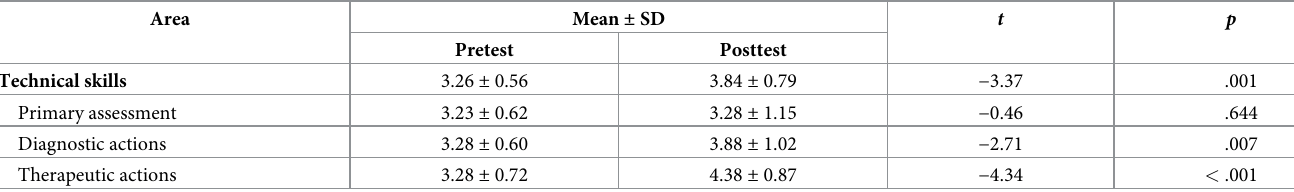
Table 1. Effects of neonatal resuscitation program simulation on technical skills. (n = 40).